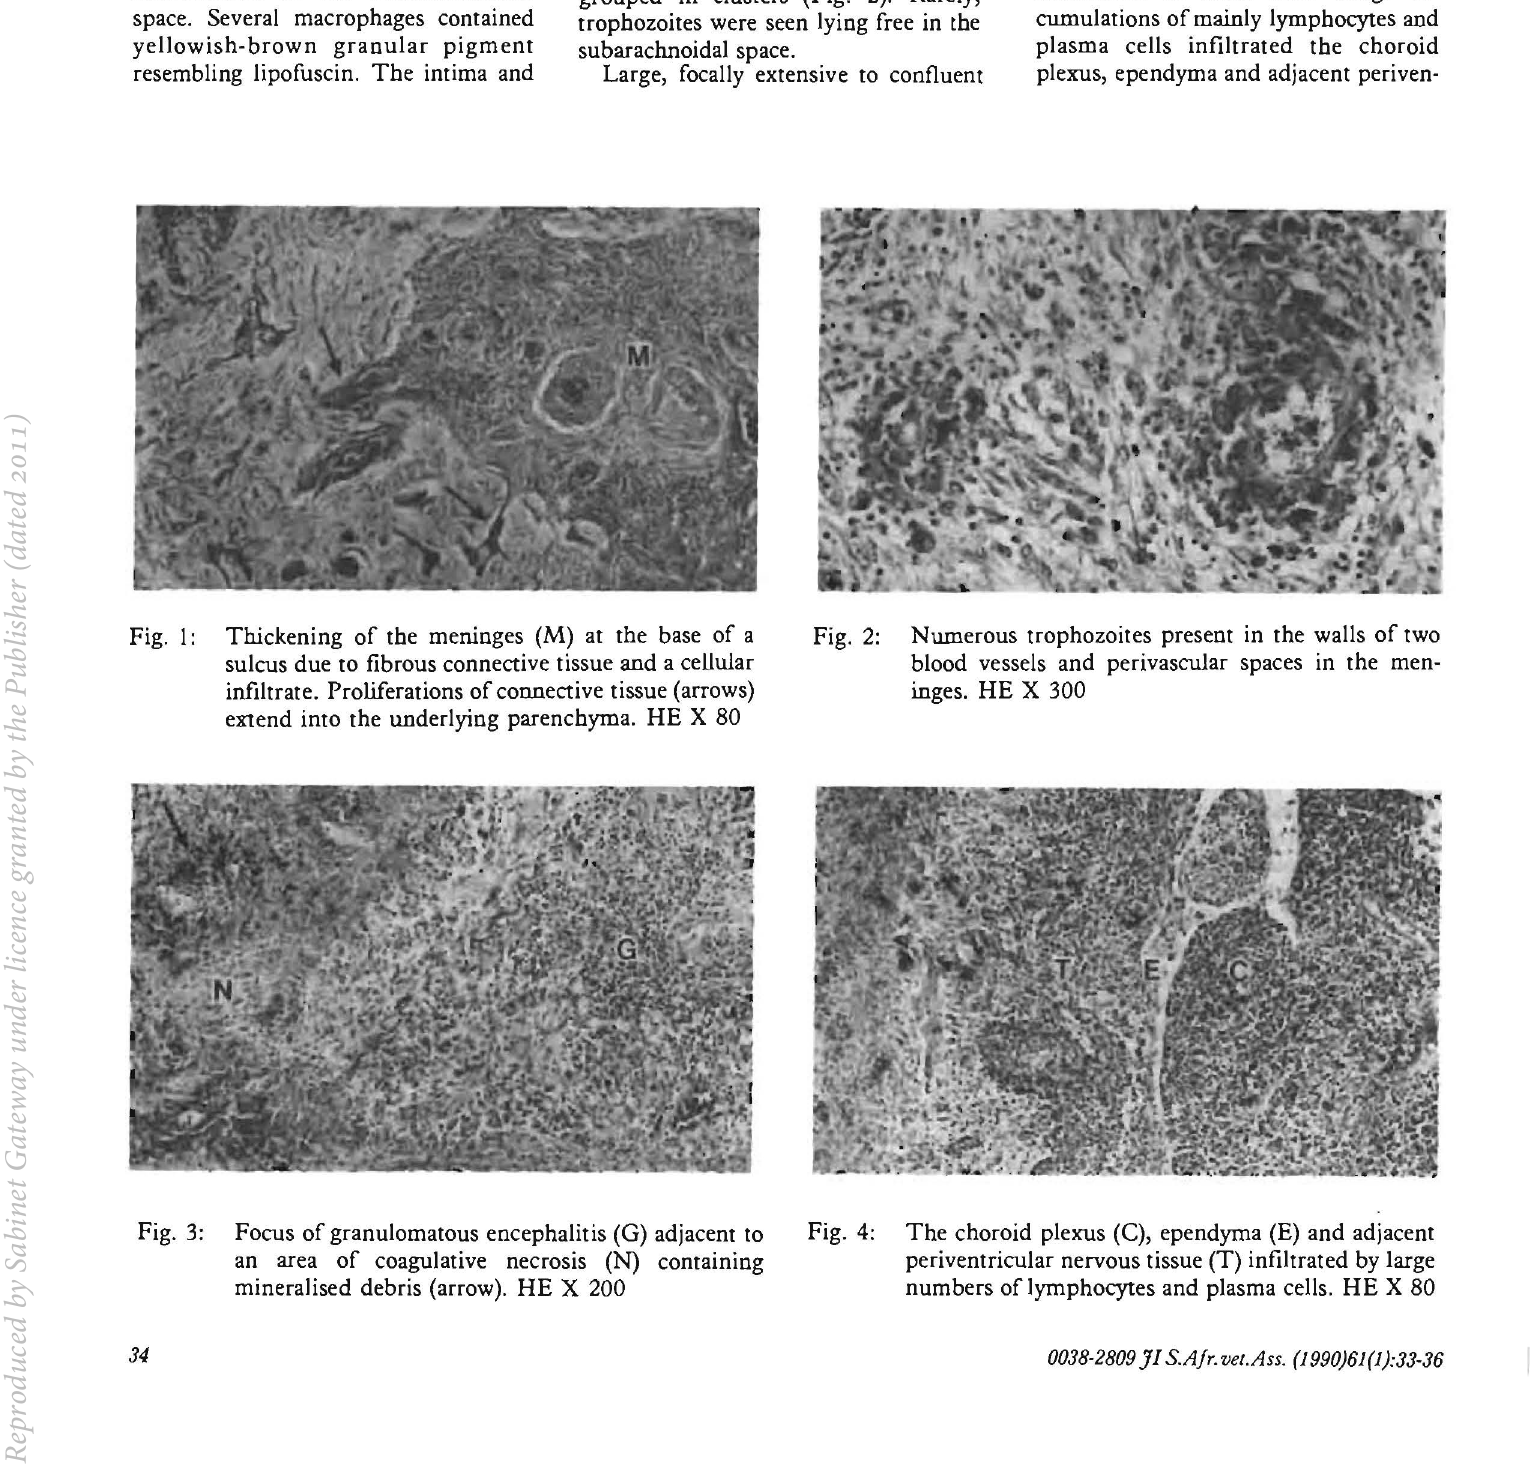
Fig. 4: The choroid plexus (C), ependyma (E) and adjacent periventricular nervous tissue (T) infiltrated by large numbers of lymphocytes and plasma cells. HE X